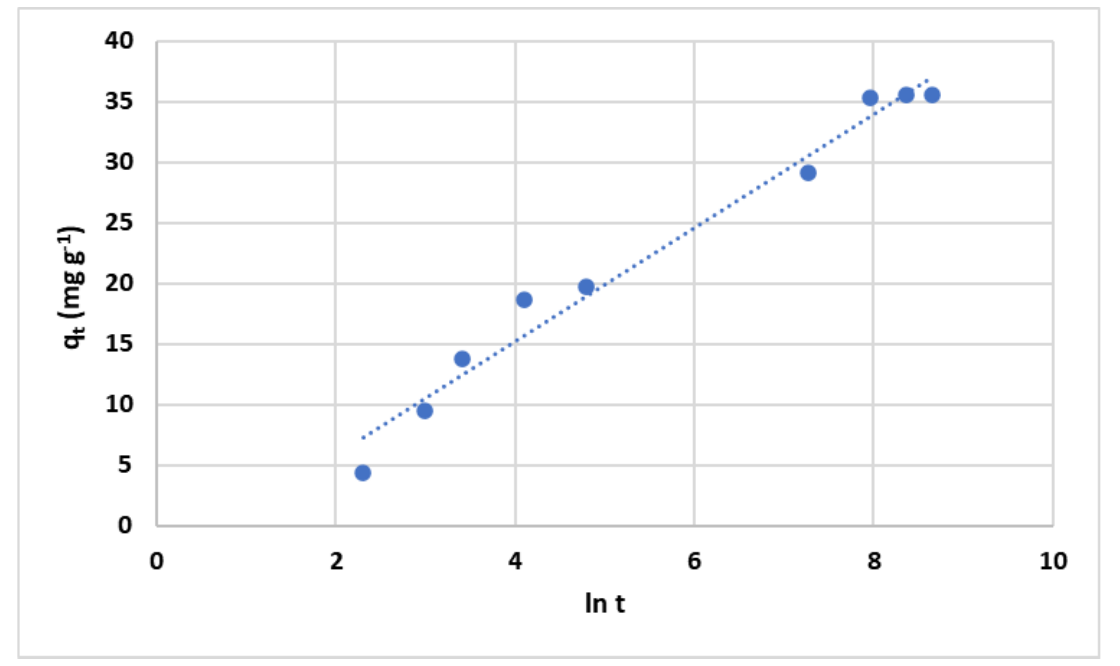
Figure 16. The model plot of pseudo-second-order for the adsorption CR dye onto 2Clph-BU-Cs